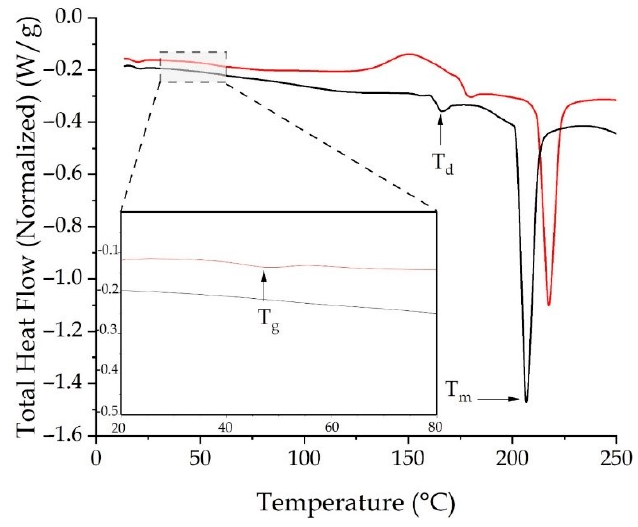
Figure 4. DSC chromatogram of PPI (black line) and SPPH (red line).